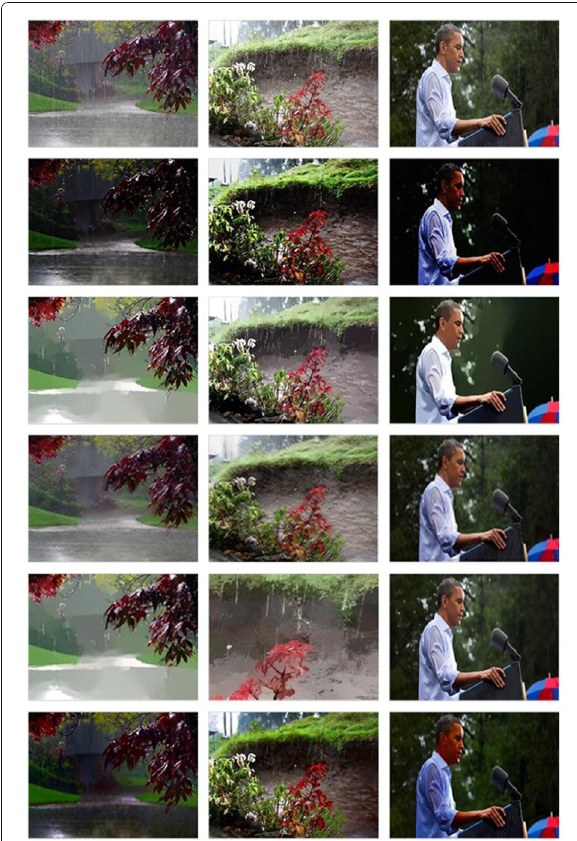
Fig. 4 Comparison of different rain removal methods on real rainy images. The top row is the input rainy images, follows in sequence are the results with Li’s method [10], Manu’s method [6], Luo’s method [5], Huang’s method [3], and our method